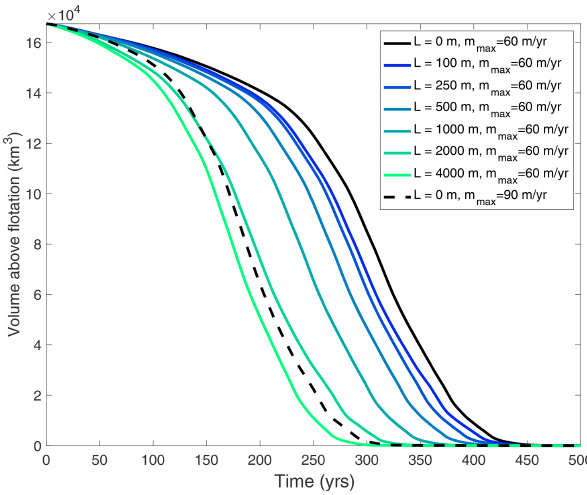
Figure 8. ISSM simulations of transient ice volume loss of Thwaites Glacier over 500 years, with varying distances of intrusion-induced basal melt upstream of the grounding line (solid colored lines) and with increased submarine melt rate with no intru- sion (dashed black line) for